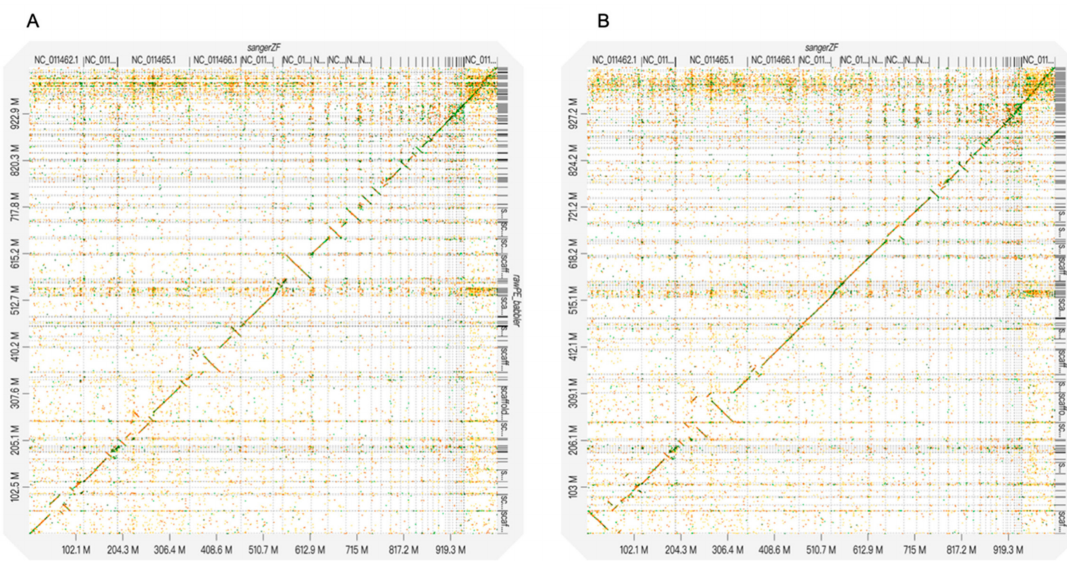
Figure 1. D-GENIES plots of the alignments between the rufous-capped babbler and zebra finch genomes. The raw PE ( A ) and trimmed PE ( B ) PLATANUS-assembled genomes are mapped to the zebra finch genome. Only the sca ff olds of the rufous-capped babbler genomes with lengths > 5000 bp were used. The unlocalized sca ff olds of the zebra finch genome were excluded from the